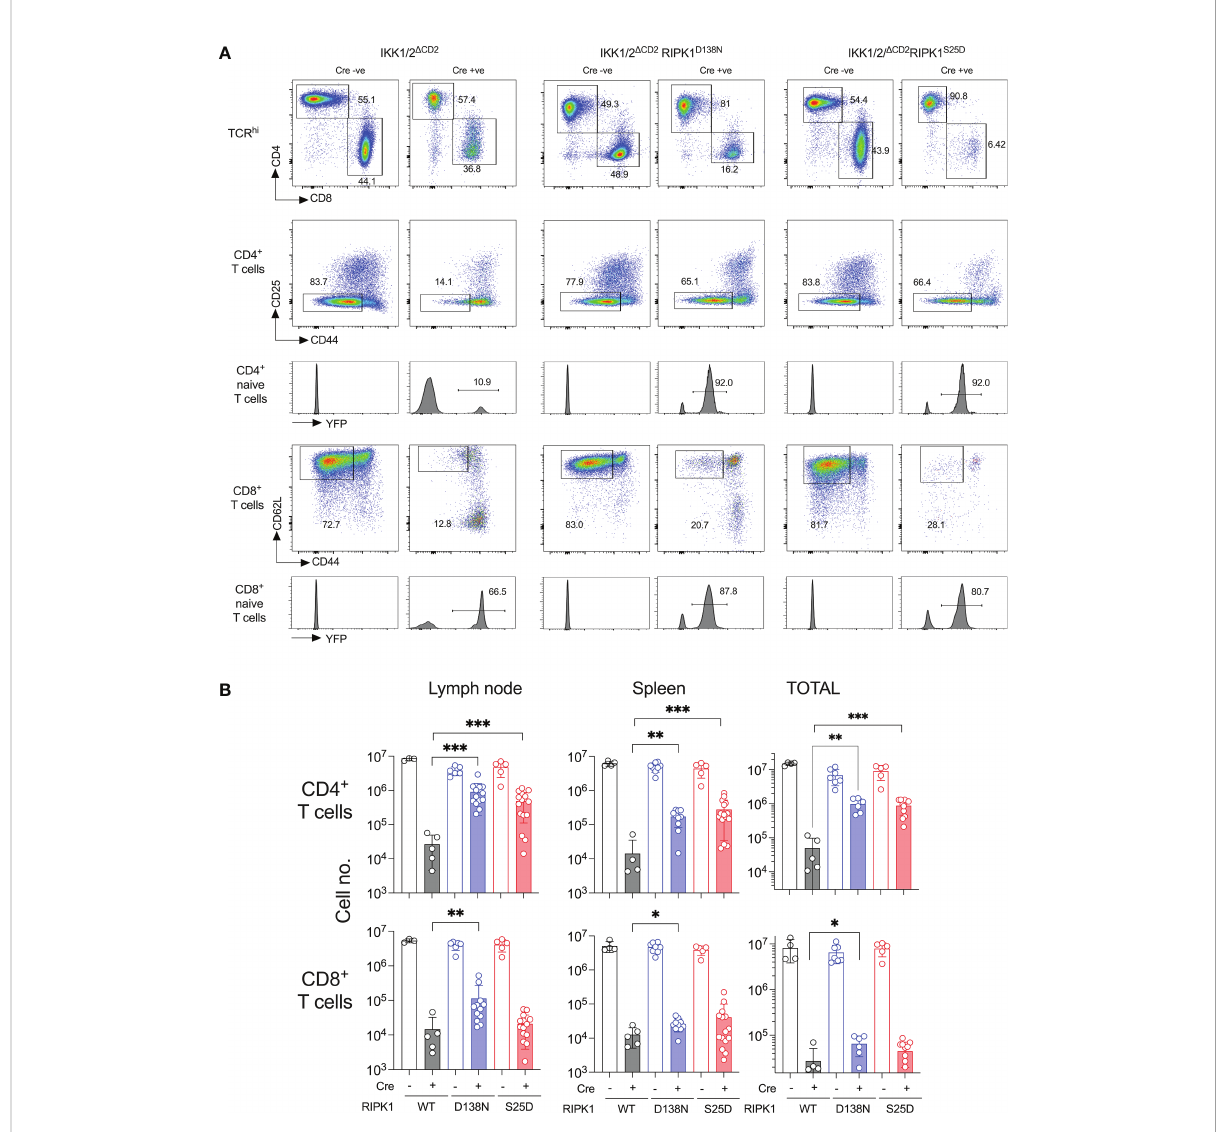
FIGURE 4 RIPK1 S25D rescues IKK de fi cient CD4 + but not CD8 + naive T cells from cell death in vivo . LN and spleen were recovered from the same groups of mice described in Figure 3 and single cell suspensions analysed by fl ow cytometry. (A) Flow plots show the phenotype of lymph node cells and gates used to identify CD4 + naive T cells as CD4 + TCR hi CD44 lo CD25 - and CD8 + naive T cells as CD8 + TCR hi CD44 lo CD25 - cells. Histograms are of YFP expression by naive gated T cells from the corresponding strains. YFP is only activated in Cre expressing strains. (B) Bar charts show the numbers of CD4 + and CD8 + naive T cells recovered from lymph nodes, spleen and both combined, from the indicated strains. Cell recoveries from Cre+ and corresponding Cre- strains were all highly signi fi cant differences (p<0.0001). Signi fi cant differences between Cre + strains are indicated on plots. Data are pooled from fi ve independent experiments. * p<0.05, ** p<0.01, ***